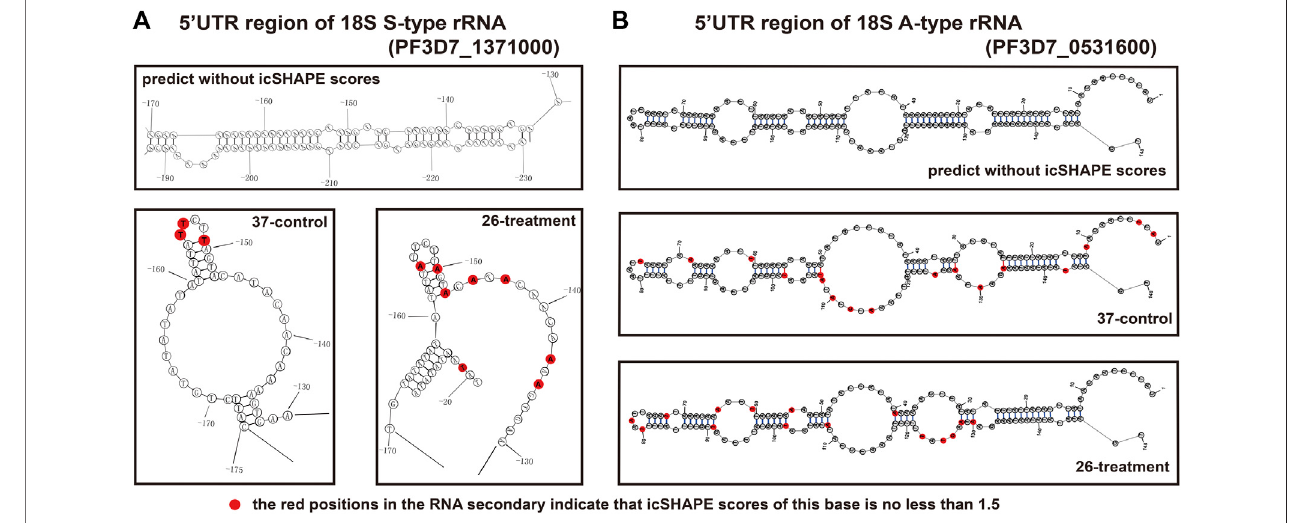
FIGURE 6 | Map of the RNA secondary structure of P. falciparum 18S A- and S-type rRNA 5 ′ -UTR. (A) Map of the RNA secondary structure of P. falciparum 18S S-typerRNA5 ′ -UTRregionwithouticSHAPEscores,37 ° CcontrolgroupwithicSHAPEscores invivo ,and26 ° CtreatmentgroupwithicSHAPEscores invivo . (B) Mapof the RNA secondary structure of P. falciparum 18S A-type rRNA 5 ′ -UTR region without icSHAPE scores, 37 ° C control group with icSHAPE scores in vivo , and 26 ° C treatment group with icSHAPE scores in vivo . The red positions in the RNA secondary structure indicate that the icSHAPE scores of this base is no less than 1.5.